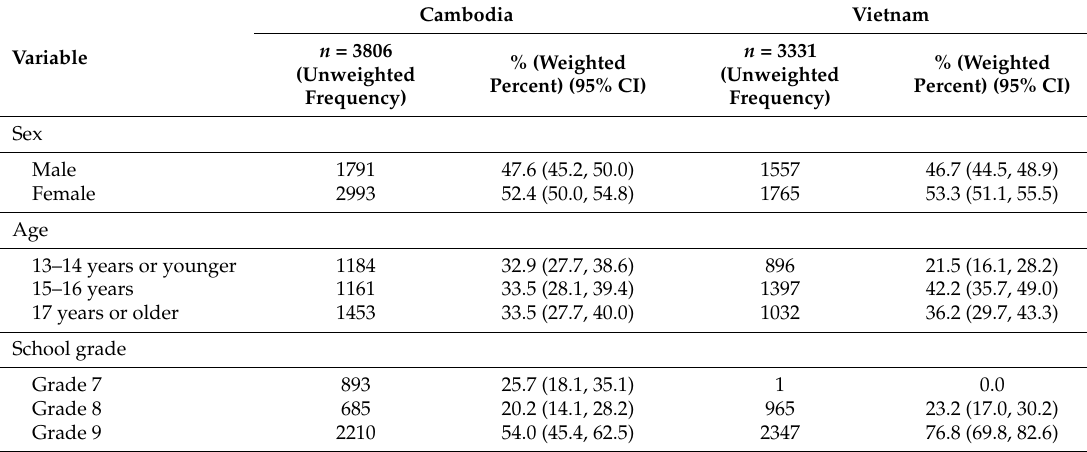
Table 2. Sample characteristics.